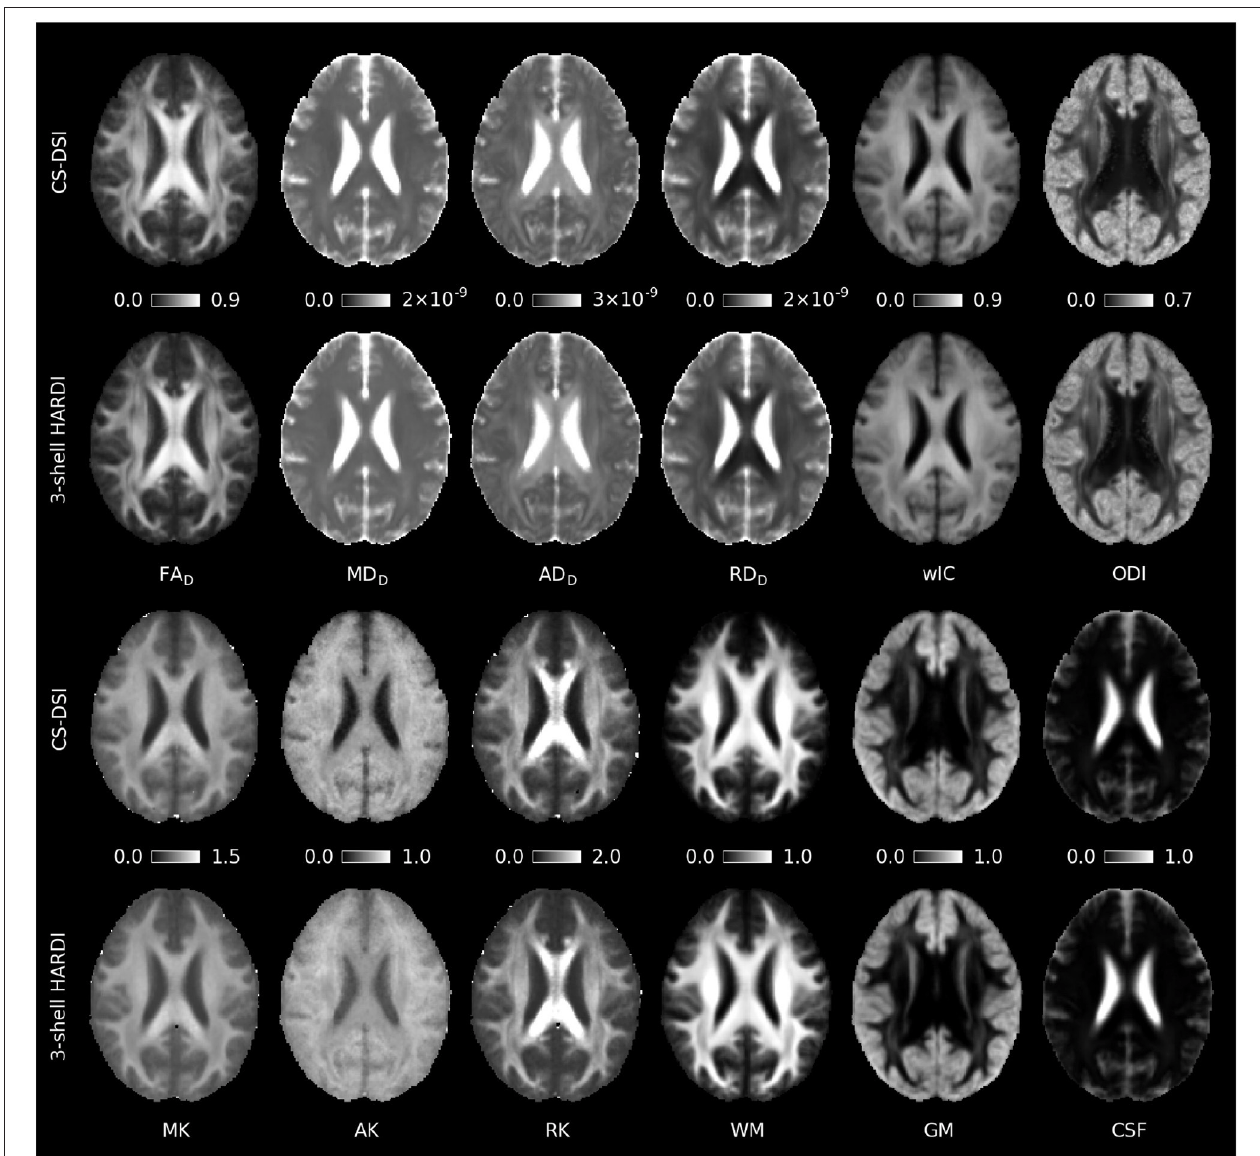
FIGURE 4 | Group averaged whole brain diffusion parameter maps estimated from CS-DSI and 3-shell HARDI acquisitions by means of the tensor (FA D , MD D , AD D , RD D ), kurtosis (MK, AK, RK), and NODDI (wIC, ODI) model. Brain tissue volume fraction maps for WM, GM, and CSF were estimated using multi-tissue deconvolution. Comparable parameter maps are obtained for both CS-DSI and 3-shell HARDI. Diffusivities are given in units of m 2 /s.